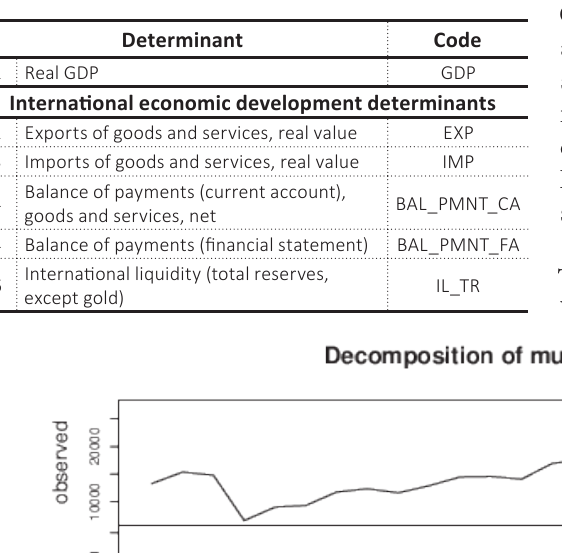
Table 1. Input data for causal analysis of state